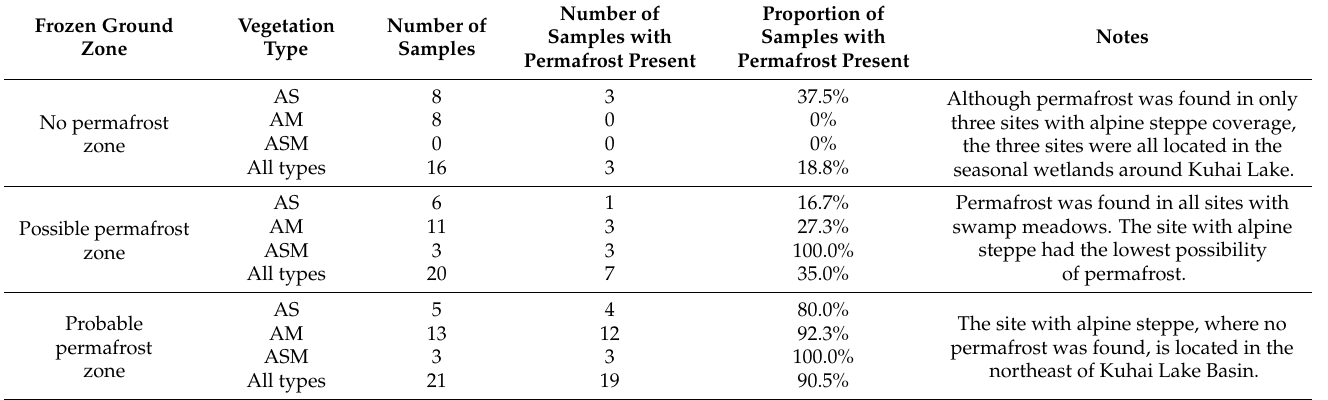
Figure 10. Statistics of land surface temperature and temperature at the lower limits of continuous permafrost and discontinuous permafrost. ( a , c ) show the data frequency and box plots of the land surface temperature at the lower limit of continuous permafrost (LLC) and the lower limit of discontinuous permafrost distribution (LLD), respectively. ( b , d ) show the data frequency and box plots of the air temperature at the LLC and LLD, respectively. Table 3. Statistics of field survey sites for different vegetation types and permafrost existence in different frozen ground zones. ASM, AM, and AS represent alpine swamp meadow, alpine meadow, and alpine steppe,